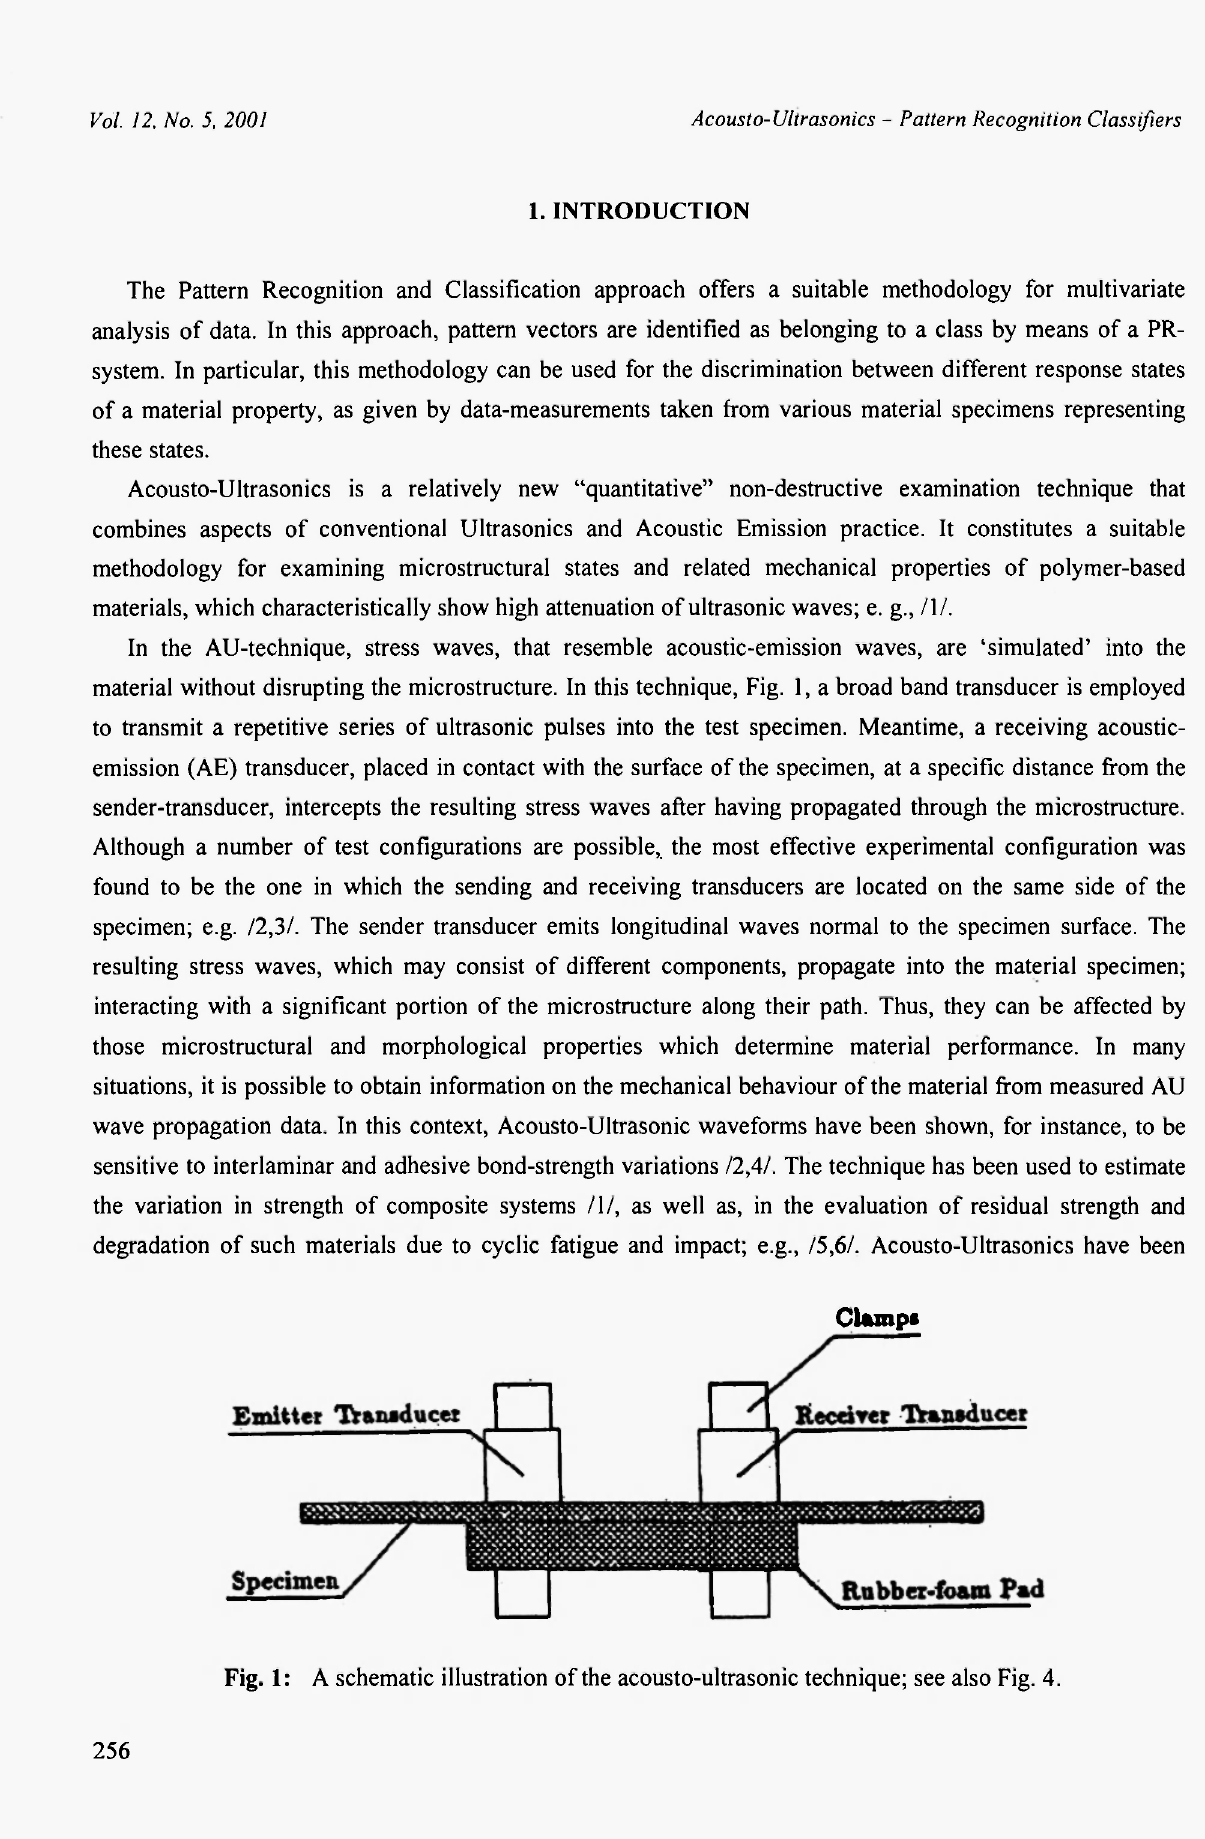
Fig. 1: A schematic illustration of the acousto-ultrasonic technique; see also Fig.